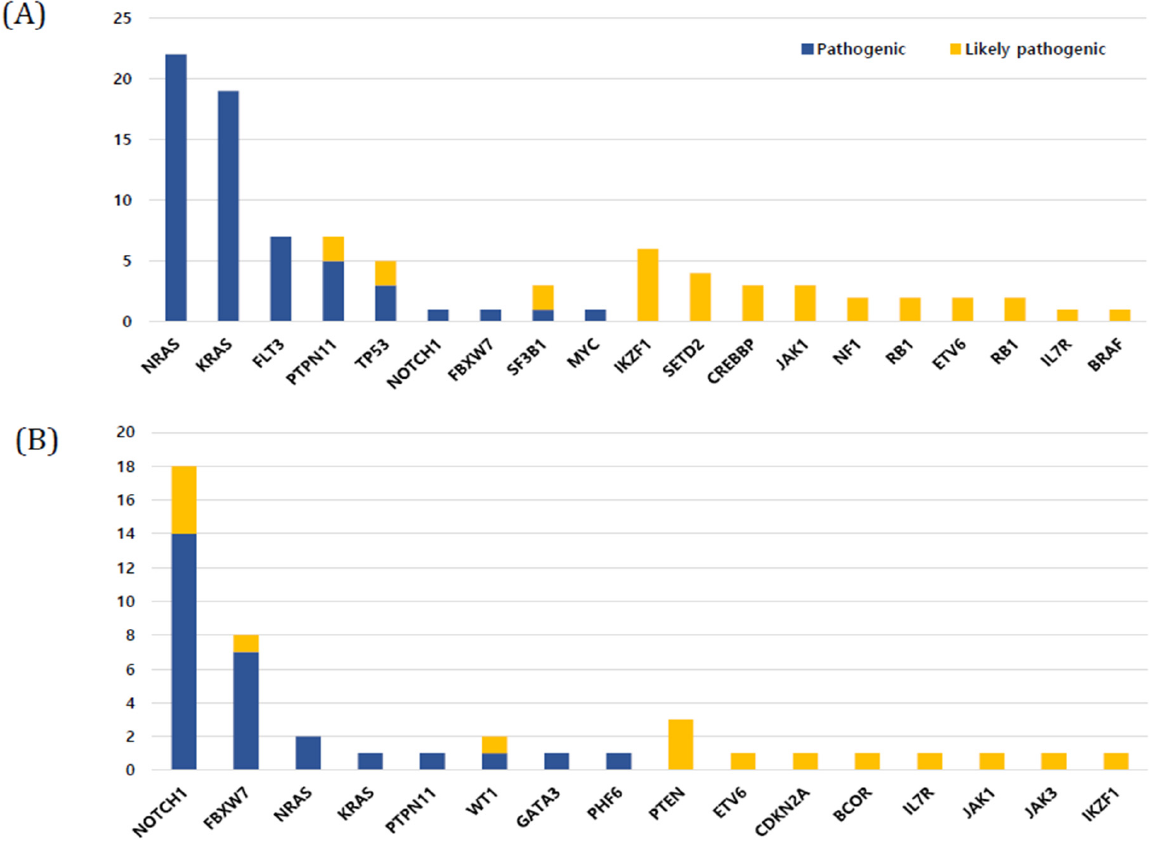
Figure 3. Frequency of mutations in study cohort. ( A ) B-cell precursor acute lymphoblastic leukemia (ALL) ( B ) T-cell ALL.